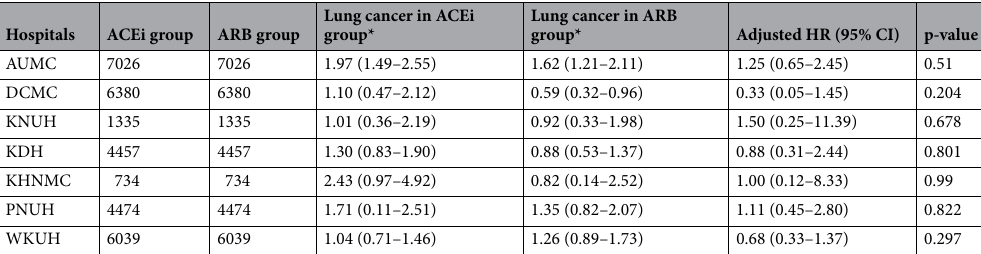
Table 3. Incidence of lung cancer in the propensity-score matched population. *Incidence rate are presented as per 1000 years (95% confidential interval). ACEi Angiotension converting enzyme inhibitor, ARB